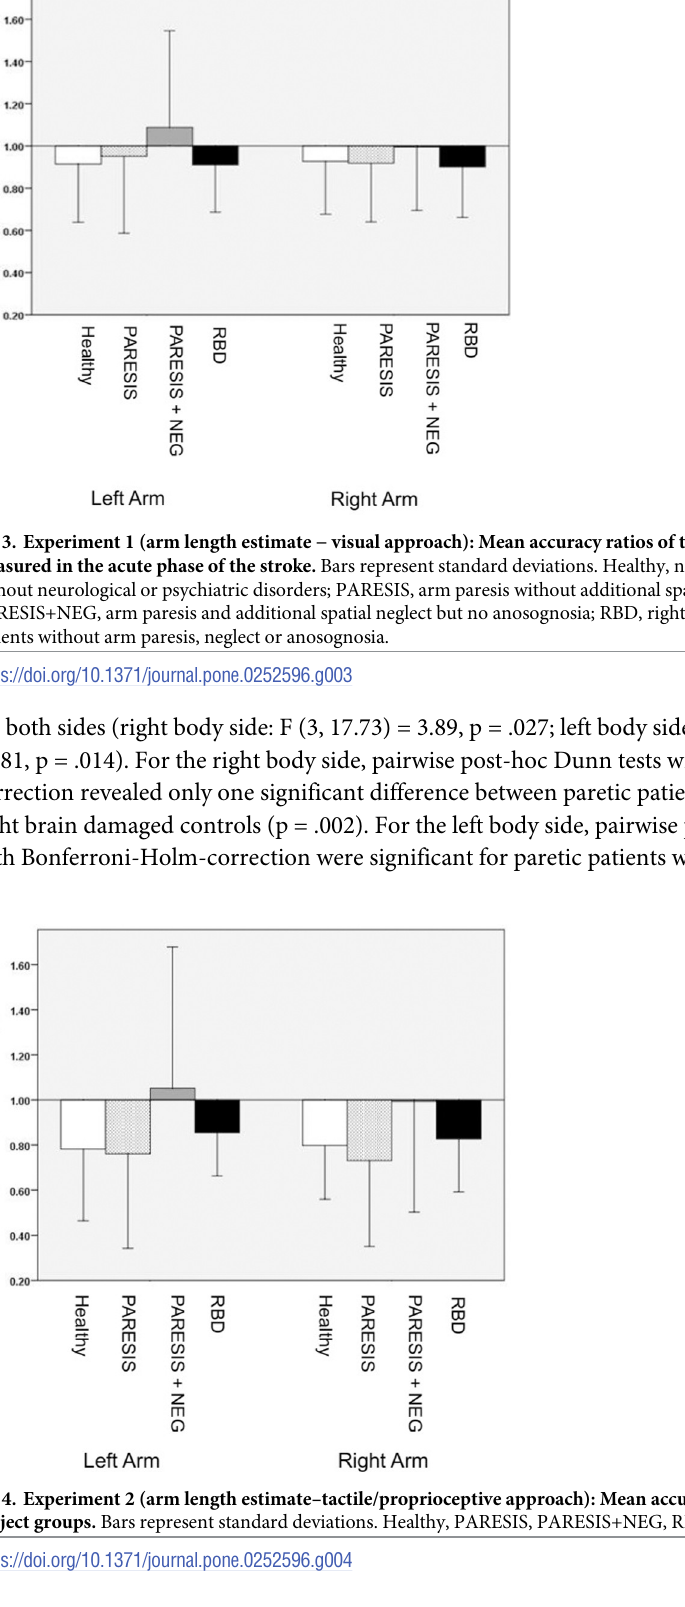
Fig 4. Experiment 2 (arm length estimate–tactile/proprioceptive approach): Mean accuracy ratios of the four subject groups. Bars represent standard deviations. Healthy, PARESIS, PARESIS+NEG, RBD as in Fig 3.